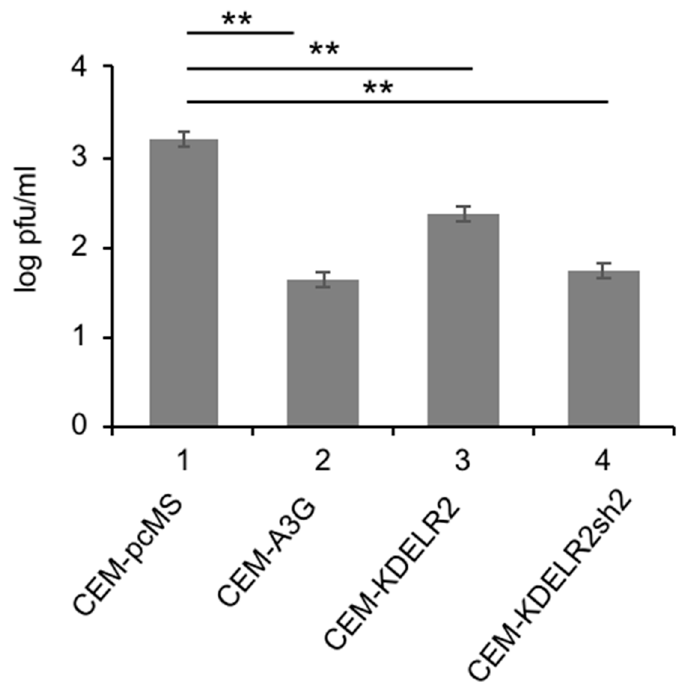
Figure 2. KDELR2 reduces MV replication in CEM-SS T cells. Transduced CEM-SS T cells were infected with MV-eGFP at a MOI of 0.1. The titer of newly synthesized virus in these cells was determined 48 h post infection on Vero cells ( n = 3). Significance was calculated using the Student’s t test (** p < 0.01).